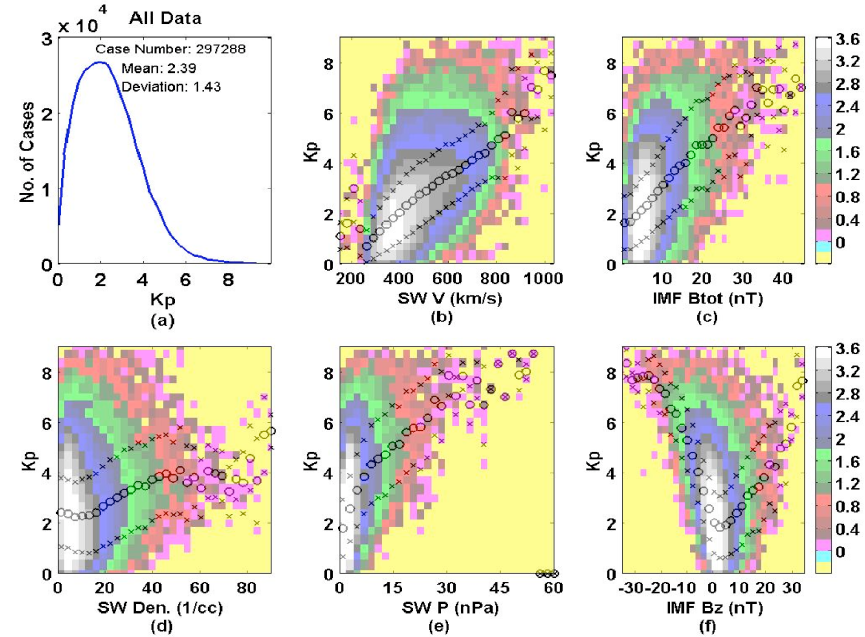
Fig. 1. Histogram of all 3-hourly K p index values (a) in 1970–2003, (b) as a function of solar wind speed V sw , (c) as a function of IMF B tot , (d) as a function of solar wind density n sw , (e) as a function of solar wind dynamic pressure P sw , and (f) as a function of IMF B z . The color scale for panels (b–f) shows the logarithms of the numbers of occurrences. Open circles show the mean K p value while the crosses indicate +/ − a standard deviation. All the distributions, though rather broad, show monotonic variations of K p with hourly solar wind and IMF input with zero time lag. We note that same K p values can result from either positive or negative IMF B z